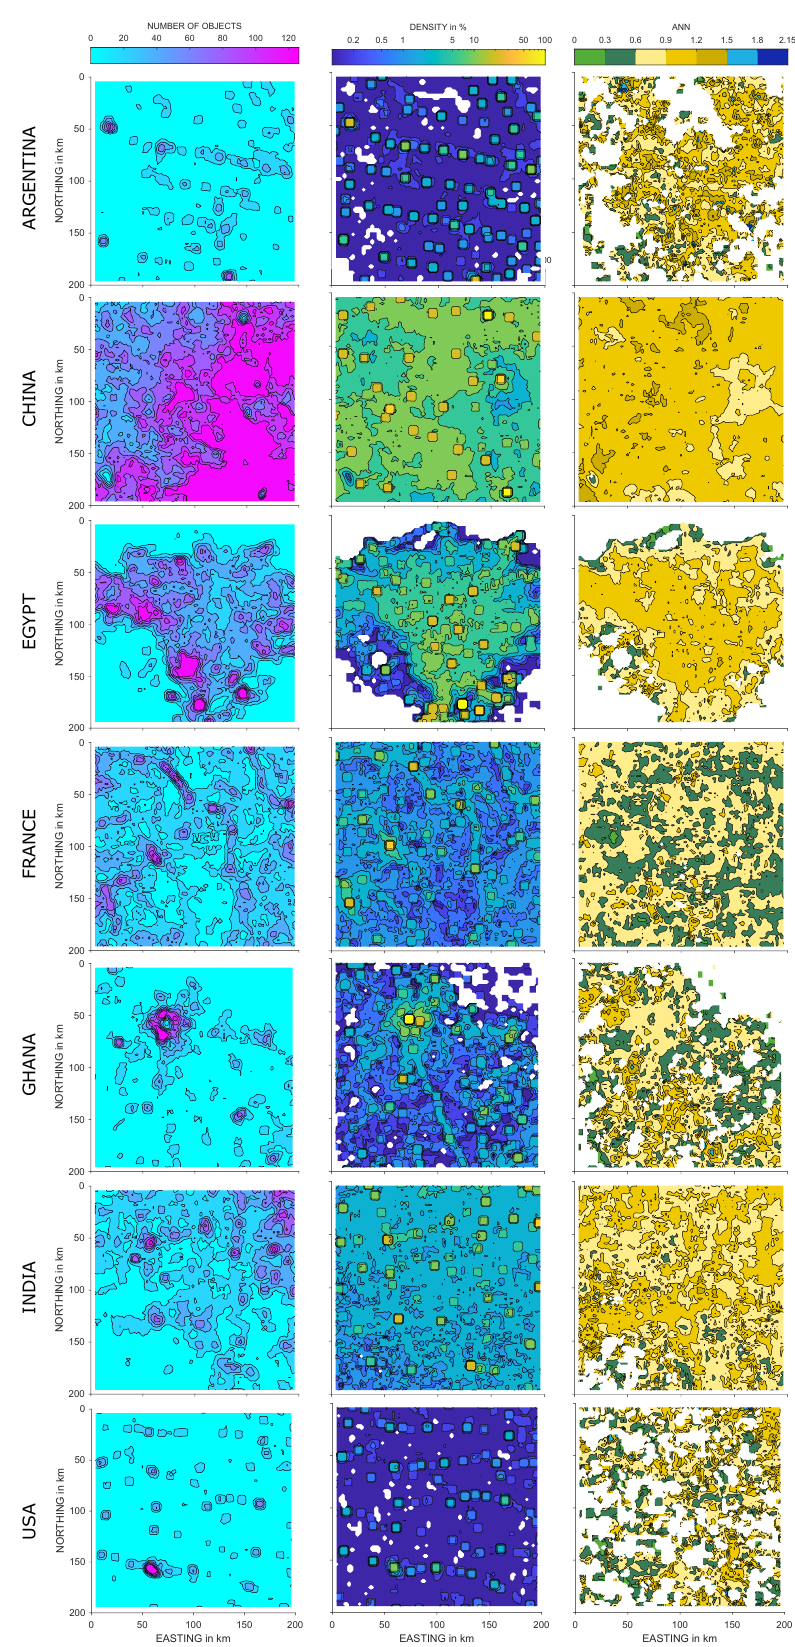
Figure 5. Number of objects, density and ANN for sliding window analysis for windows of sample size of 8